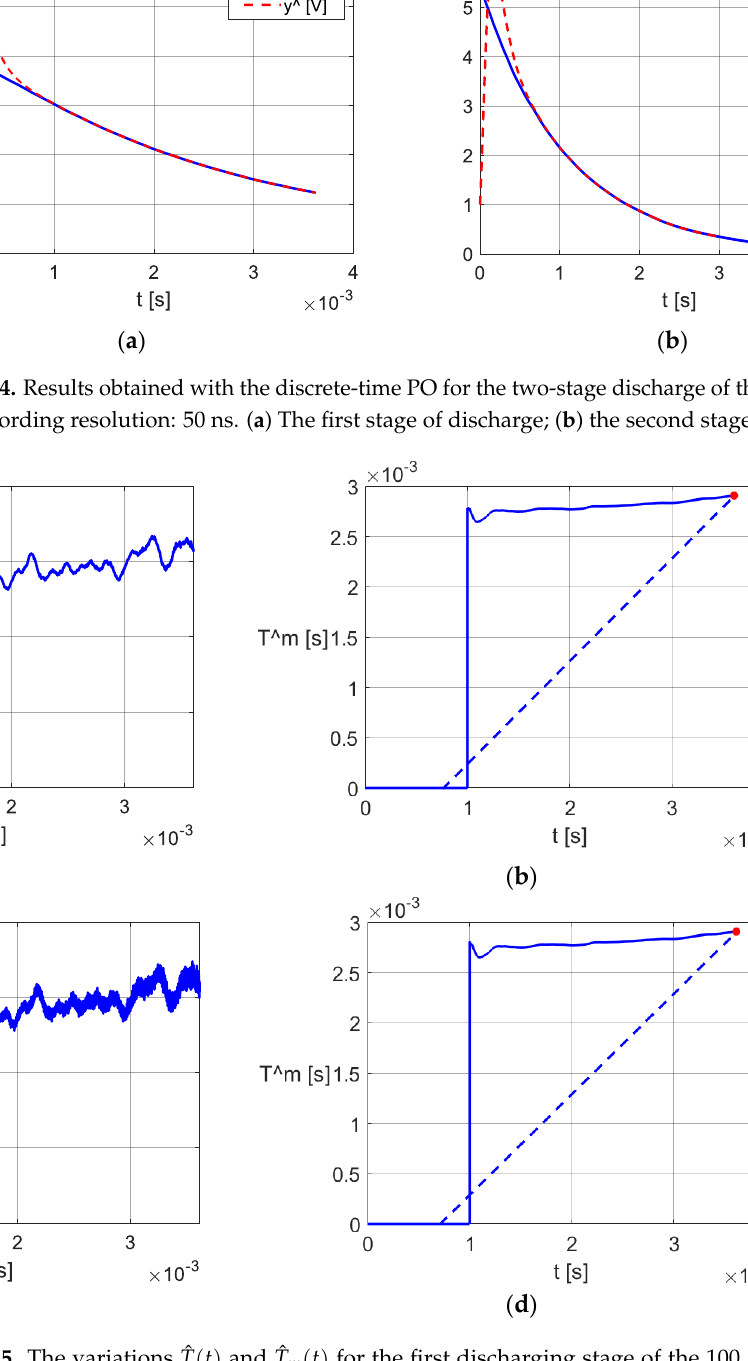
Figure 15. The variations ˆ T ( t ) and ˆ T m ( t ) for the first discharging stage of the 100 µ F capacitor in Figure 14a calculated using a discrete-time PO for: ( a , b ) filtered data; ( c , d ) unfiltered data.